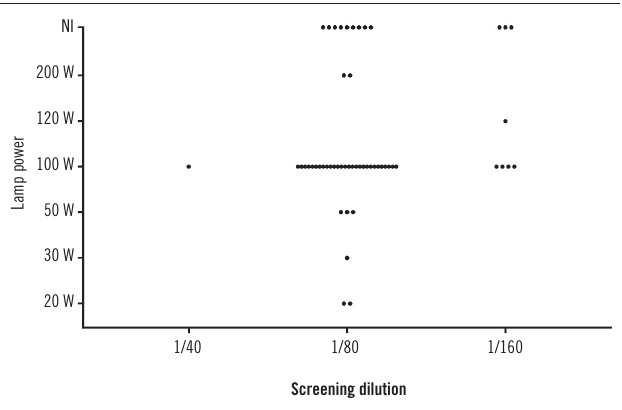
figurE 2 − Relationship between screening dilution and lamp power of the microscope used to read the indirect immunofluorescence slides in 53 Brazilian laboratories NI: not informed; W: Watts.